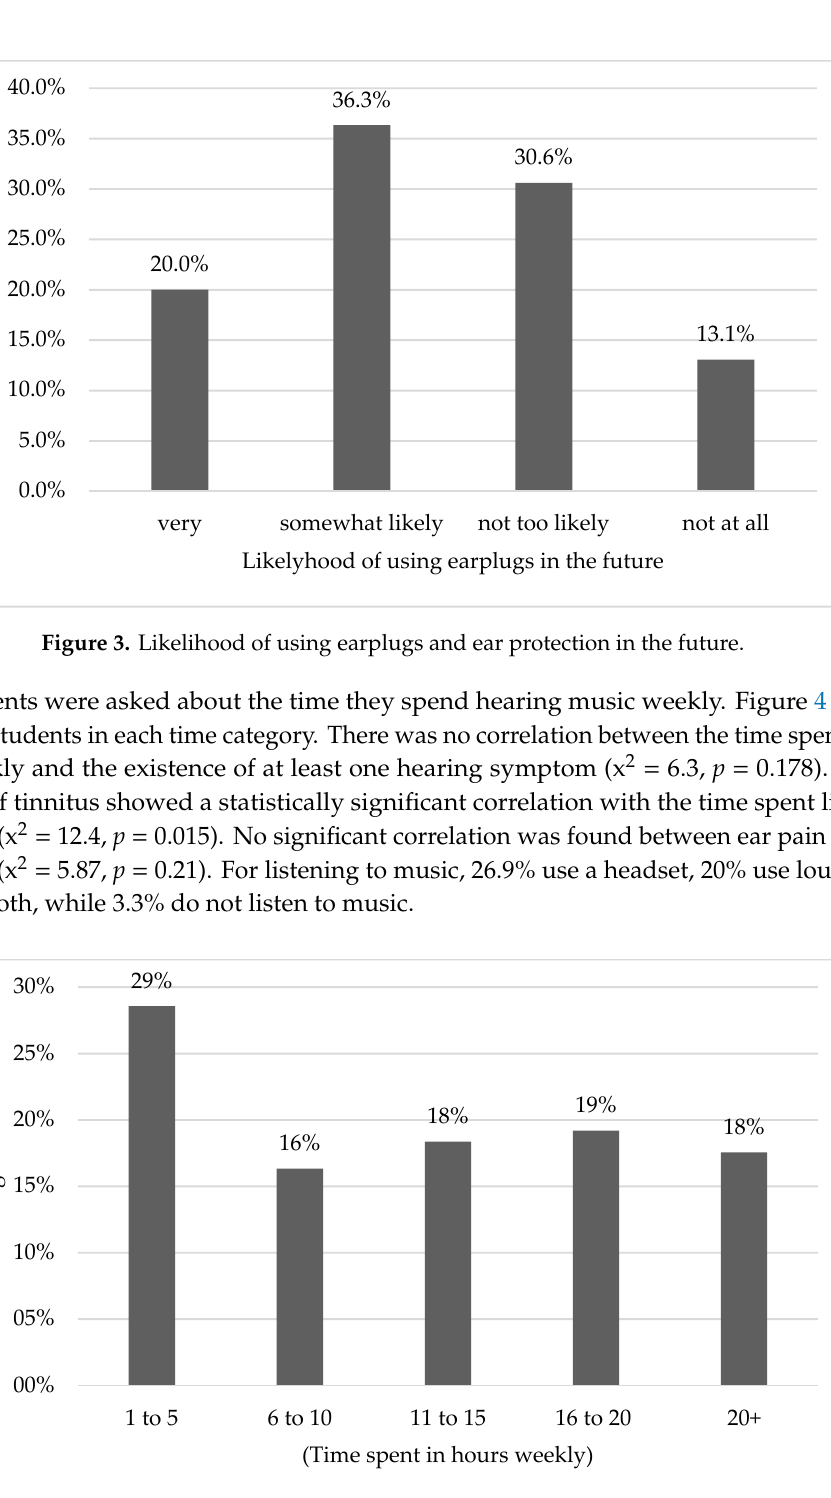
Figure 4. The time spent listening to music and using audio devices weekly.